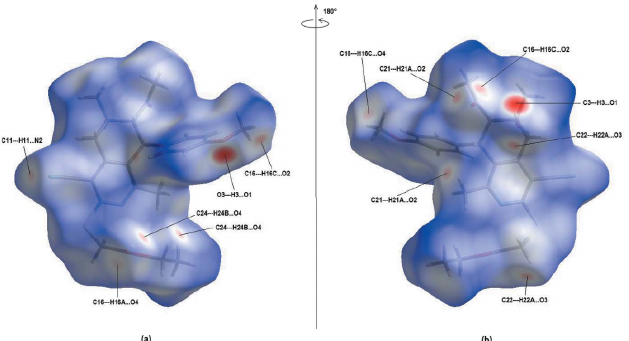
Figure 4 ( a ) Front and ( b ) back sides of the three-dimensional Hirshfeld surface of the title compound mapped over d norm , with a fixed colour scale of (cid:4) 0.4903 (red) to +1.6396 (blue) a.u.